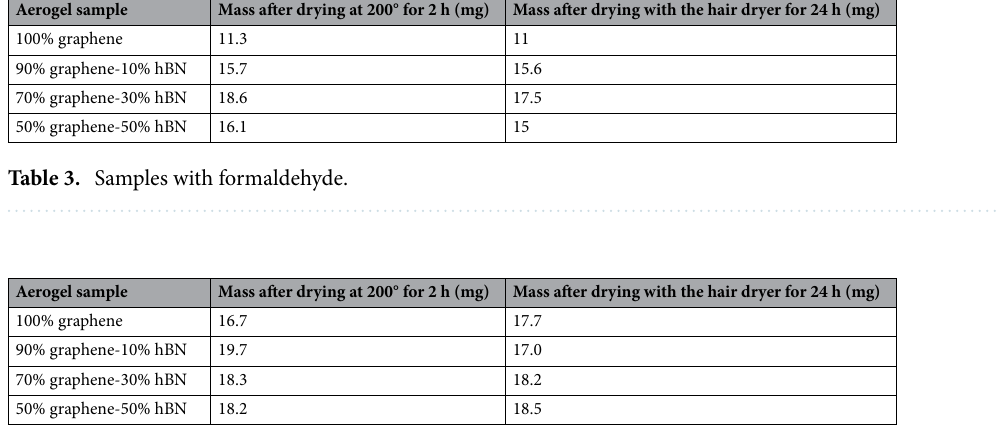
Table 4. Samples with hydrochloric acid.